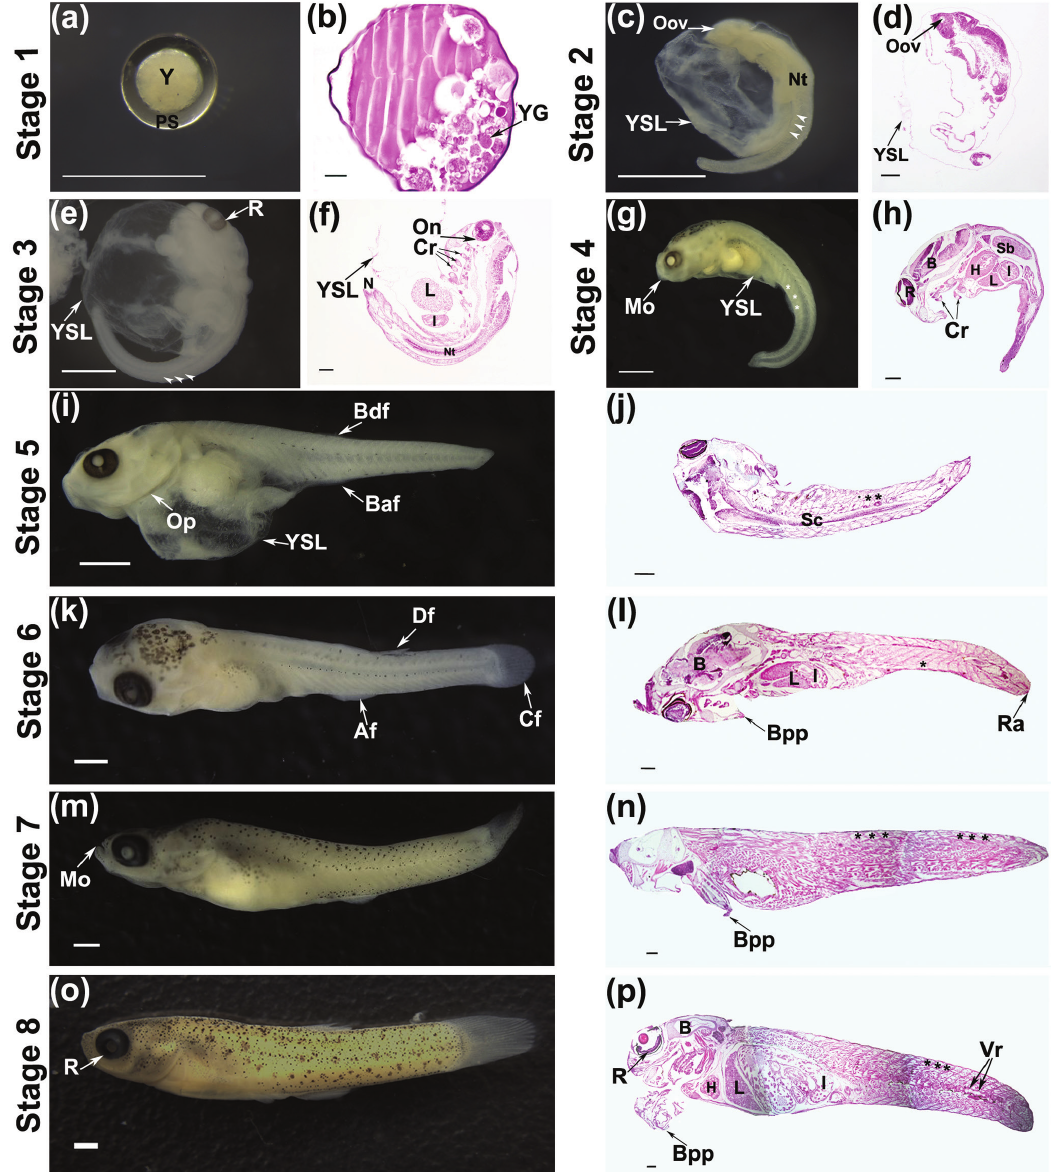
Fig. 1. Stereoscopic (a, c, e, g, i, k, m, o) and light microscopy (b, d, f, h, j, l, n, p) images stained with Hematoxylin and Eosin of the stages of embryonic development of the one-sided livebearer Jenynsia multidentata . Y: yolk; PS: perivitelinic space; YG: yolk granule; Oov: outline optic vesicle; YSL: syncytial layer of the yolk; R: retine; Arrow head: somites; Nt: neural tube; L: liver; I: intestine; On: optic nerve; Cr: crest of branchial arch; Mo: mouth opening; *: miomers; B: brain; H: heart; Sb: swimbladder; Op: operculum; Baf: bud of the anal fin; Bdf: bud of the dorsal fin; Sc: spinal cord; Df: dorsal fin; Af: anal fin; Cf: caudal fin; Ra: rays of caudal fin; Bpp: branchial Pseudoplacenta; Vr: vertebra. Scale bars of 0.5 mm (a, c, e, g, i, k, m, o) and of 0.2 mm (b, d, f, h, j, l, n, p). Stage 5: Sprouts of the dorsal and anal fins . The head Stage 6: Intrusion of ovarian folds . The embryo was was more developed. The arrangement of the dorsally fully distended and cephalic and corporal regions of the punctiform melanophores resembled a heart. The body gets body attained greater proportionality. The pigmentation was thicker, and in most embryos, the trunk is fully distended. the most conspicuous feature for the identification of this The total length was approximately of 5 mm. Punctiform phase. It was possible to identify three lines of punctiform melanophores were scattered along the flanks. The remnants melanophores along the dorsum, one in each sideline and one of YSL were still visible in some embryos. The operculum at the base of the dorsal and anal fins, and the concentration and the dorsal and anal fins were visible (Figs. 1 i-j). of large punctate chromatophores on the back of the